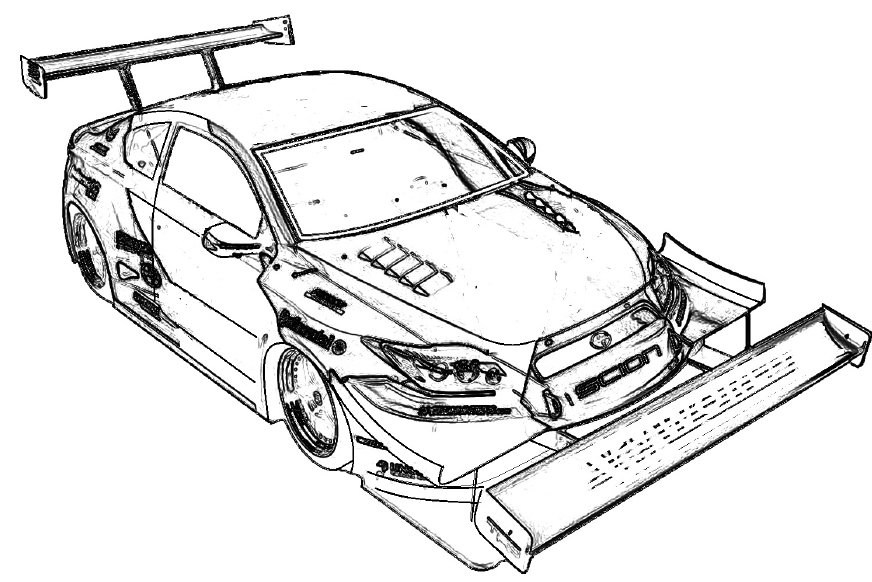
Figure 3. Scion with low front